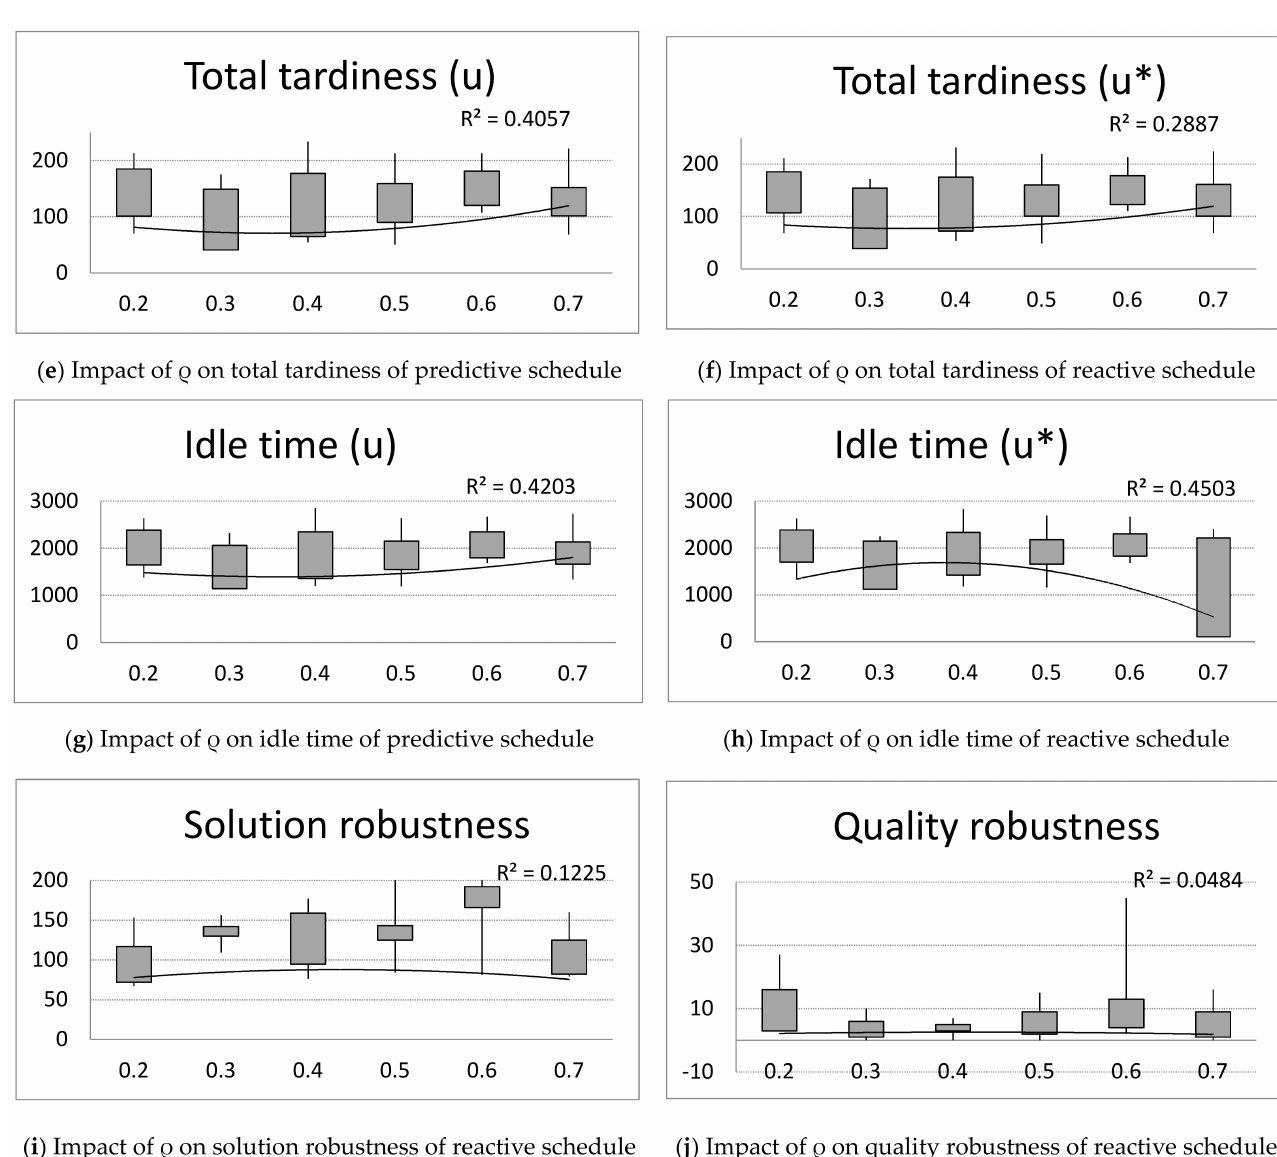
Figure 2. The impact of pheromone evaporation factor ρ = {0.2, 0.3, 0.4, 0.5, 0.6, 0.7} on makespan, flow time, total tardiness, and idle time of predictive schedules (u) and reactive schedules (u*) and solution robustness and quality